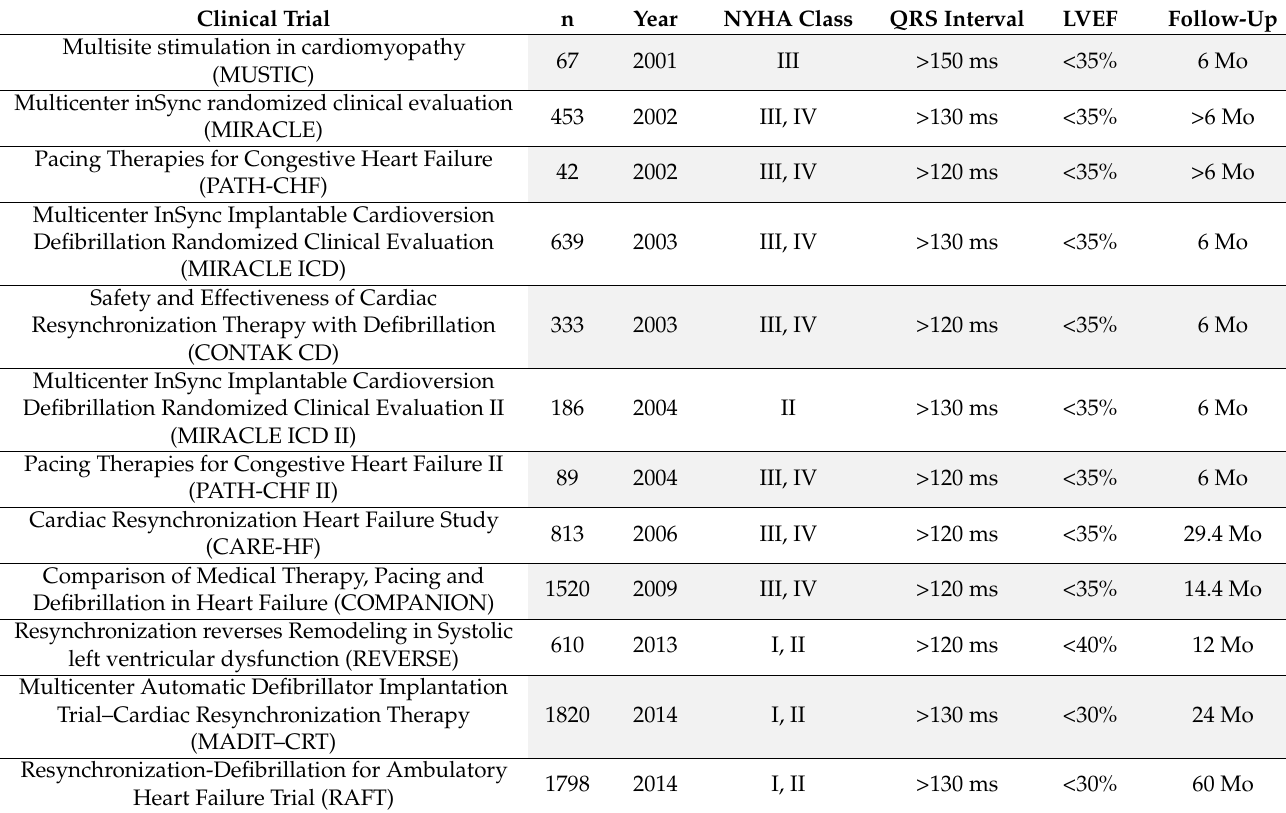
Table 1. Studies endorsing the utility of cardiac resynchronization